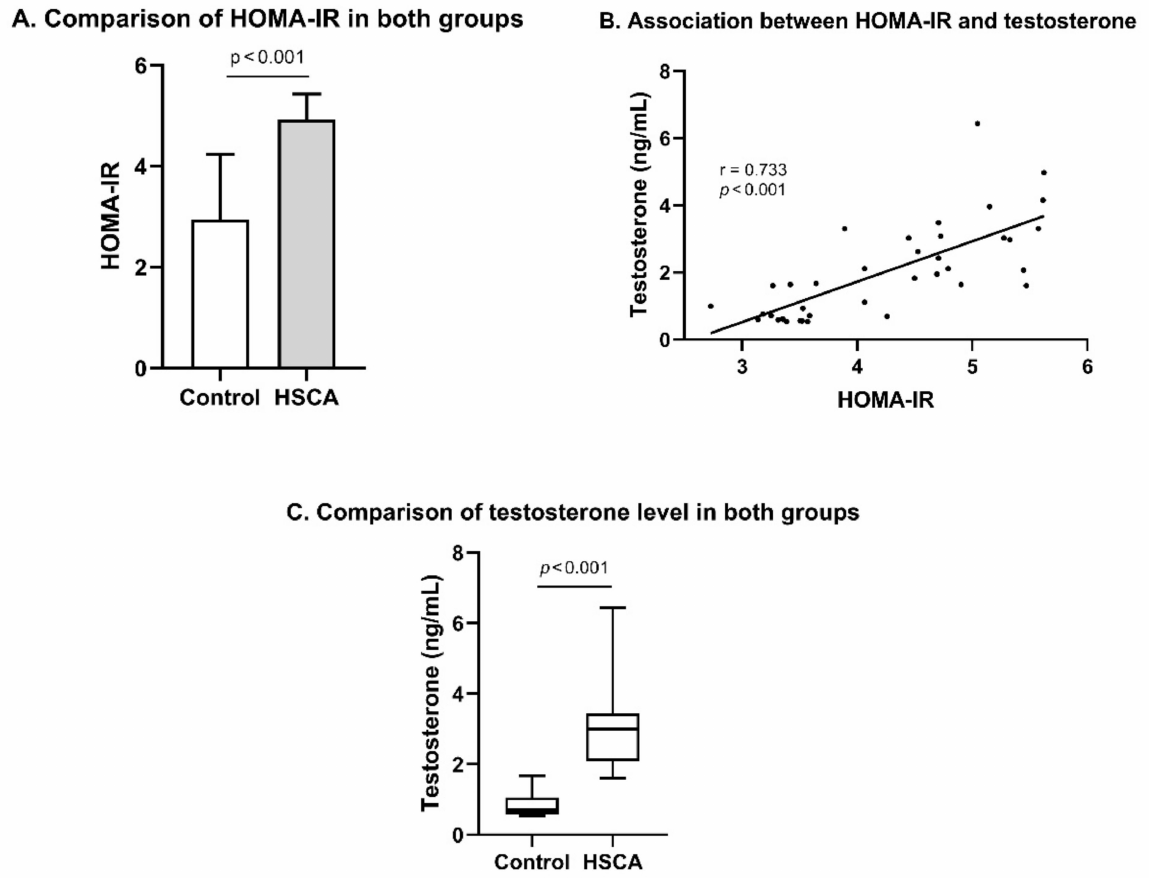
Figure 2. HSCA diet led to impaired insulin sensitivity and an enhanced testosterone level. HSCA diet increased HOMA-IR (multiplication of fasting insulin and blood glucose multiplication) ( A ). HOMA-IR, Homeostatic Model Assessment for Insulin Resistance. Data are presented as mean ± SD, statistical Student’s t -test. HOMA-IR was positively correlated with testosterone level ( B ), with a high level of testosterone presented in the HSCA-ingested rats, compared to that in control rats ( C ). Data are presented as median with minimum and maximum values, statistical Mann–Whitney U